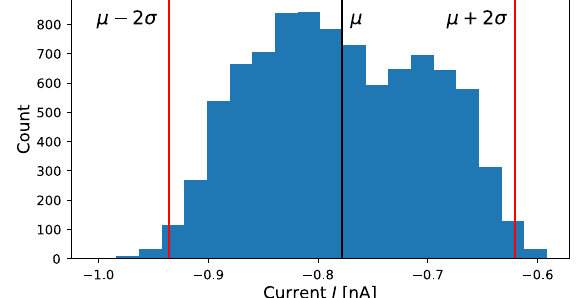
FIG. 18. Histogram of current values at data points outside the defined beam region.